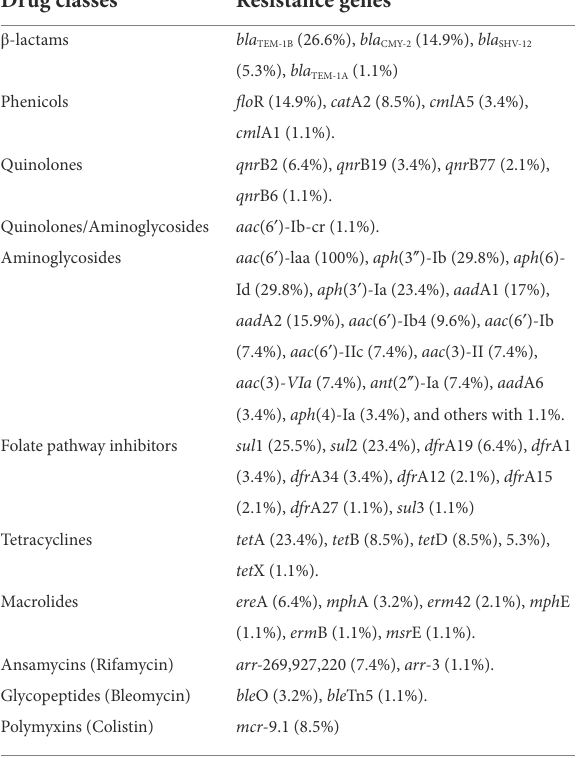
TABLE 1 Antimicrobial resistance genes of the 94 Salmonella Senftenberg isolates. Drug